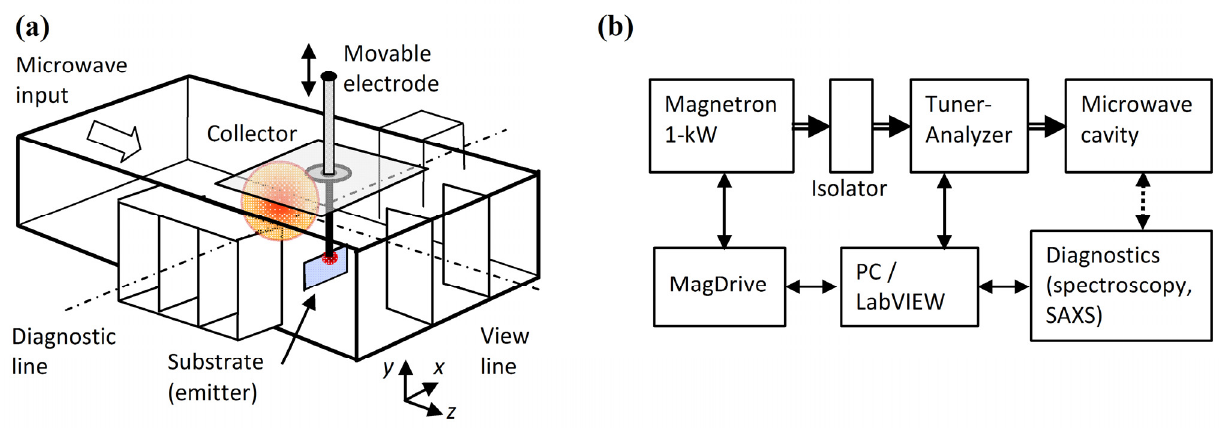
Figure 1. The experimental setup: ( a ) The microwave cavity with a movable electrode directing the localized microwaves into the substrate, thus creating a hotspot from which the fireball is ejected to the air atmosphere within the cavity; and ( b ) A block diagram of the experimental